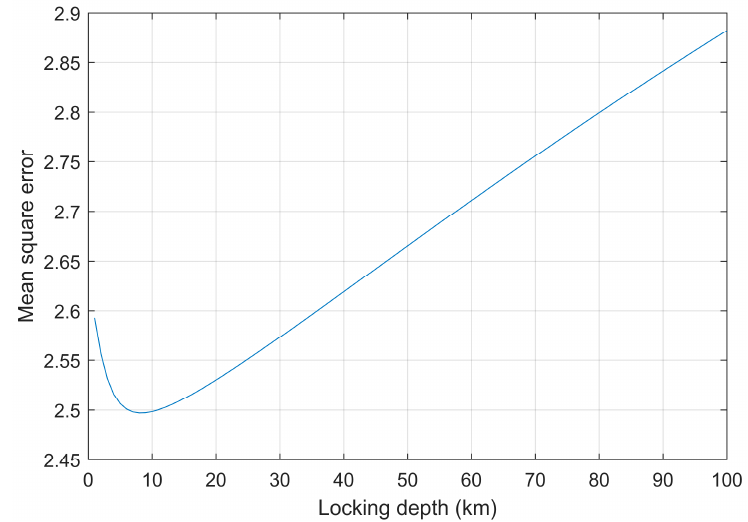
Figure 6. Relationship between the mean square error and the locking depth.